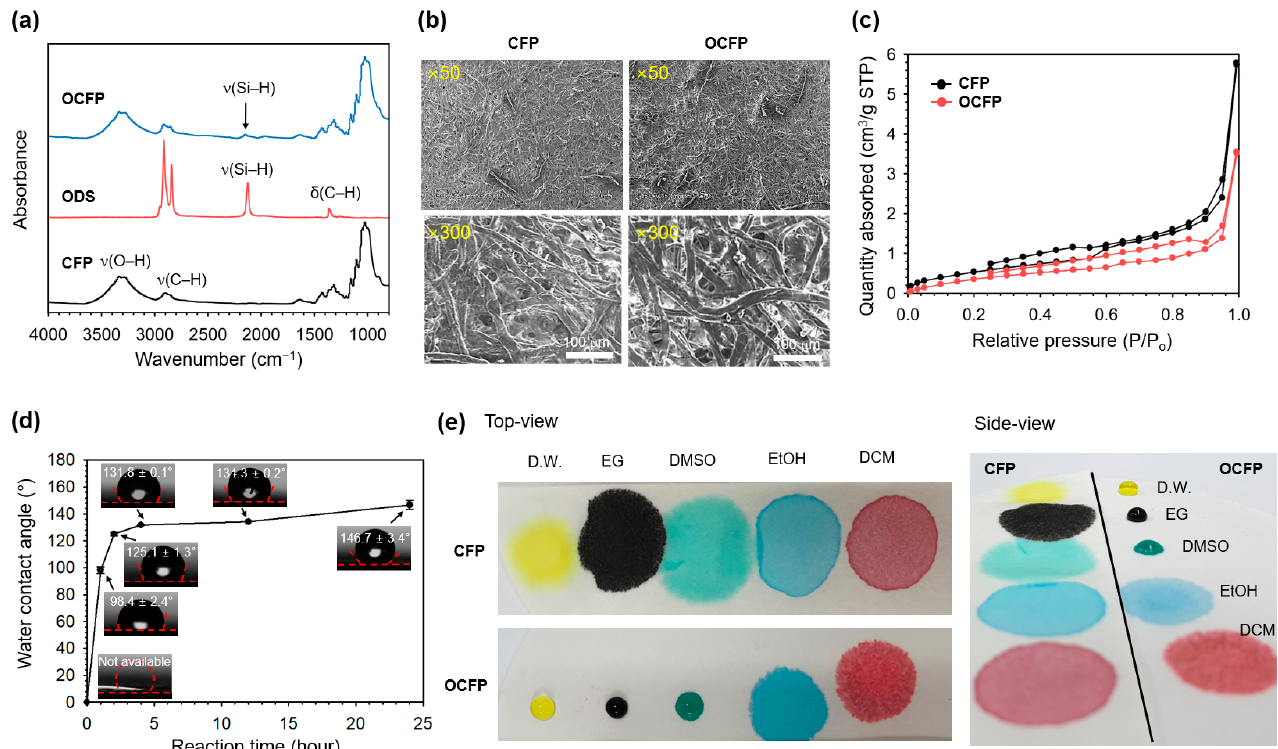
Figure 2. Characterization of ODS-coated cellulose-based filter paper (OCFP). ( a ) Attenuated total reflectance Fourier transform infrared (ATR-FTIR) spectra of the cellulose-based filter paper (CFP), octadecylsilane (ODS), and OCFP. Symbols: ν = stretching and δ = bending. The CFP showed bands associated with the C–OH groups: a broadband for ν (O–H) at 3600-3000 cm − 1 and ν (C–H) at 3000–2840 cm − 1 . ODS had two bands at 2100 cm − 1 associated with ν (Si–H) and at 1380 cm − 1 derived from the aliphatic chain. ( b ) Scanning electron microscope (SEM) images of the CFP and OCFP. The scale bar is 100 µ m. ( c ) Nitrogen adsorption-desorption isotherms for CFP and OCFP. ( d ) Variation in the water contact angle on the surface of OCFP and reaction time. ( e ) Top-view (left) and side-view (right) photographs of the various solvents; deionized water (D.W.), ethylene glycol (EG), dimethyl sulfoxide (DMSO), ethanol (EtOH), and dichloromethane (DCM) on CFP and OCFP.